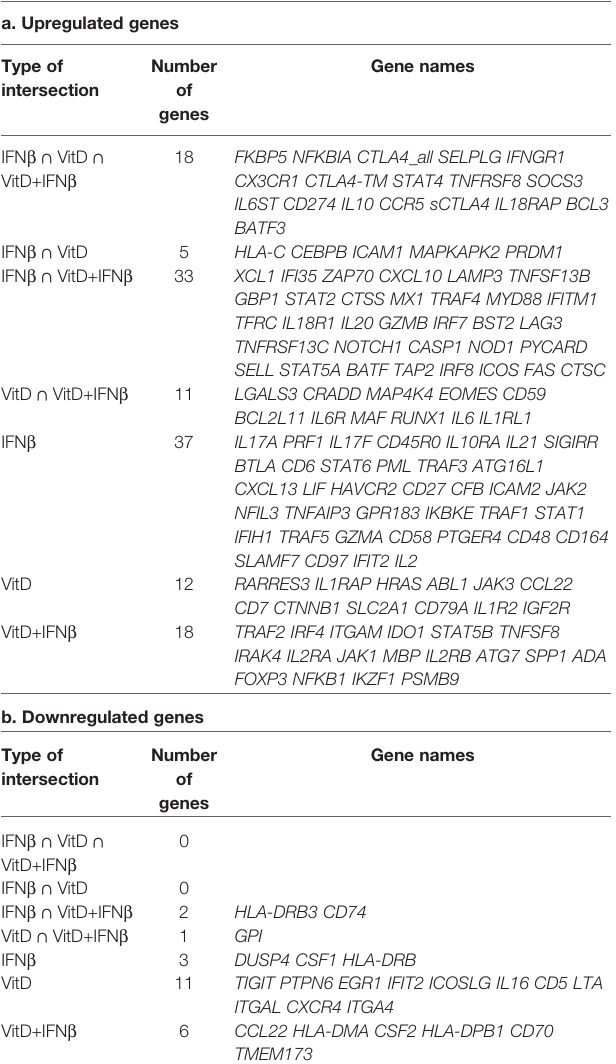
TABLE 1 | Genes up- or down-regulated by the